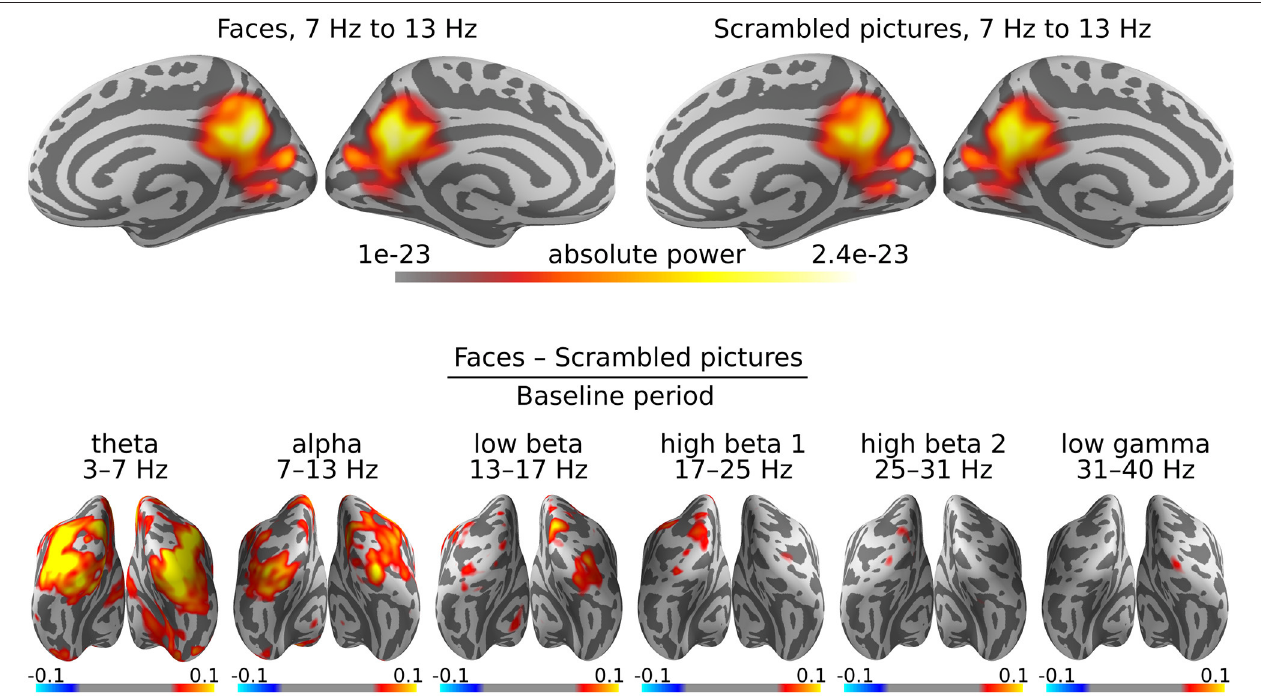
FIGURE 3 | DICS grand average power maps. Cortical activity is visualized on an “inflated” version of the cortex, so as not to hide activity within the sulci. (Top) Estimation of cortical origins of oscillatory activity in the alpha band. In this case, the inflated view makes it seem there are three sources of alpha power, but in reality, these sources are adjacent on the original white matter surface. (Bottom) Contrasts between faces and scrambled images for all frequency bands. Warm colors indicate sources with more activity for faces than scrambled images and cold colors indicate sources with